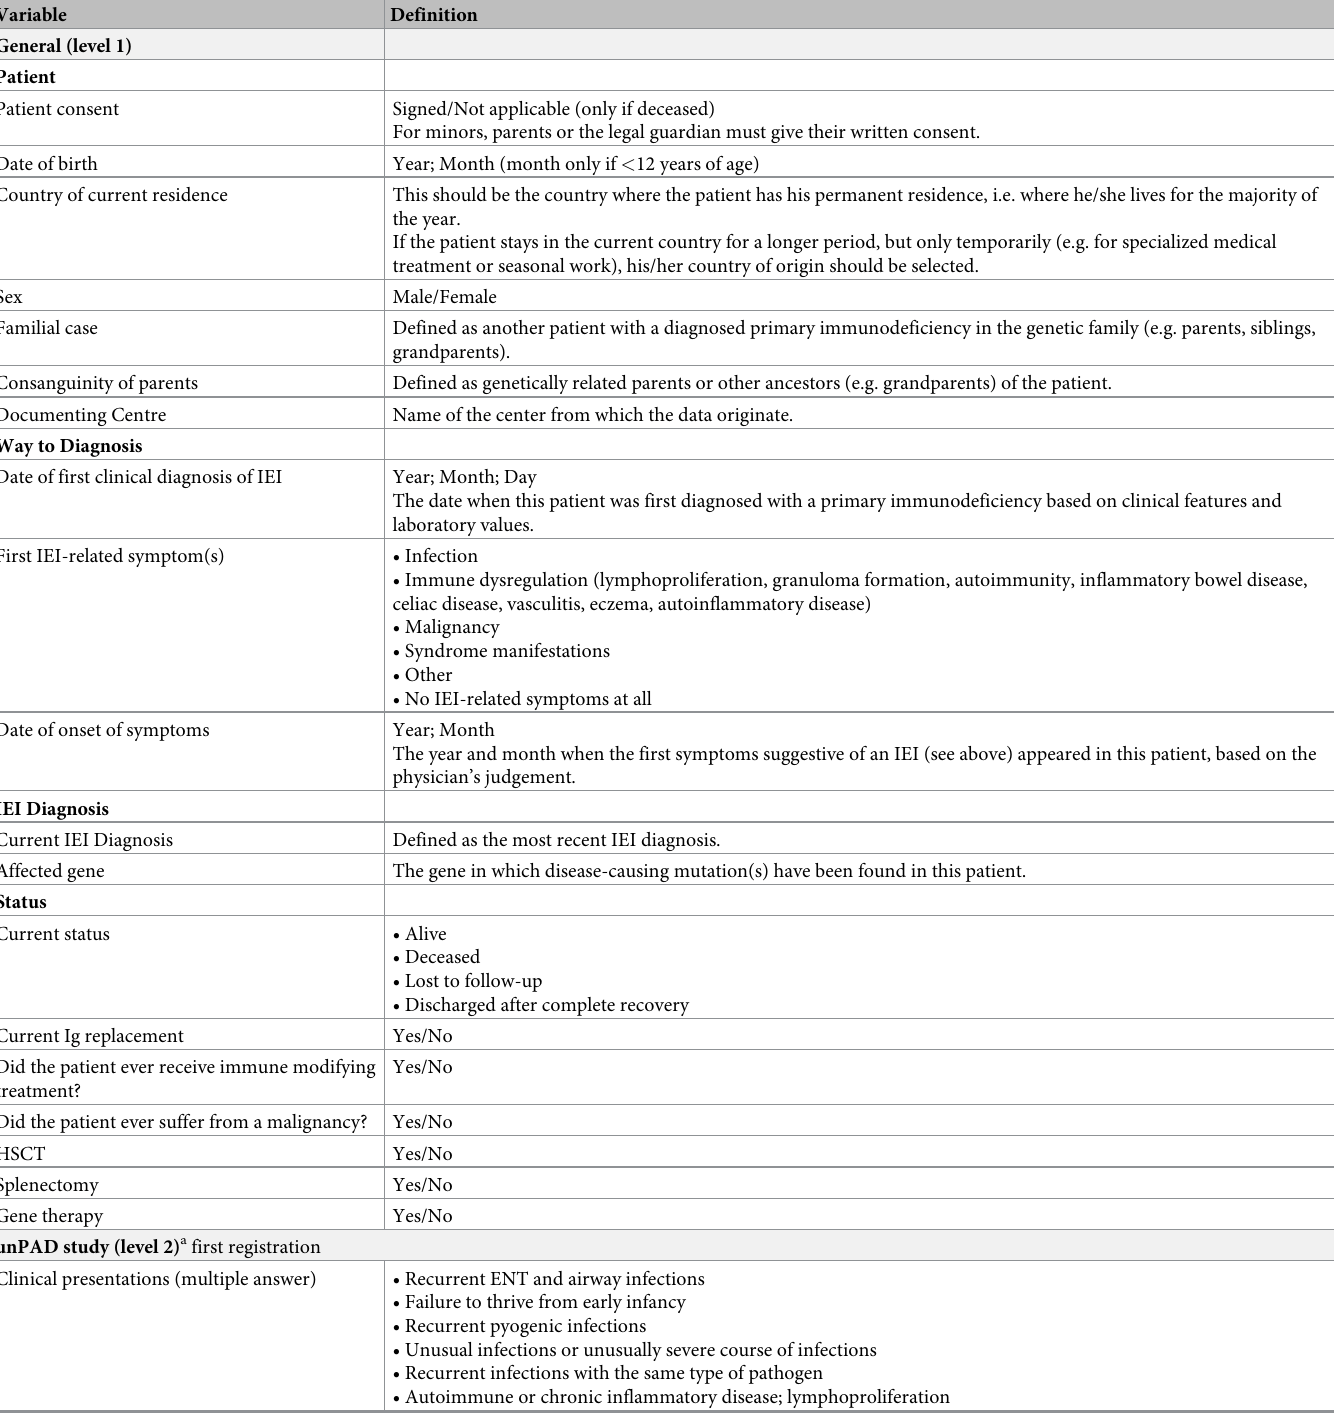
Table 3. Overview of variables included in the unPAD